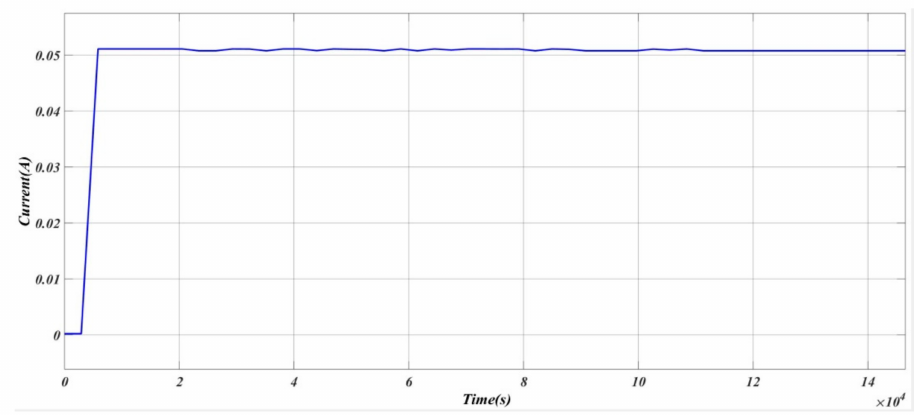
Figure 6. The pattern of the discharging current applied to the